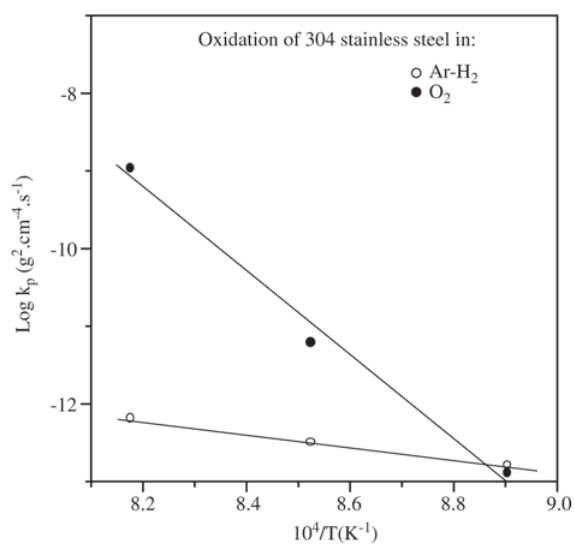
Figure 13. Arrhenius plot of the parabolic oxidation constants of 304 and 439 steels in Ar-H